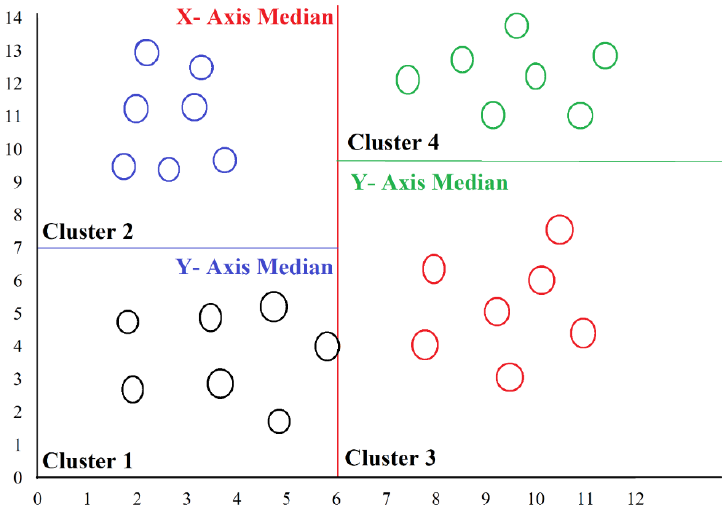
Figure 5. A pictorial view of the k dimensional-tree working principle.